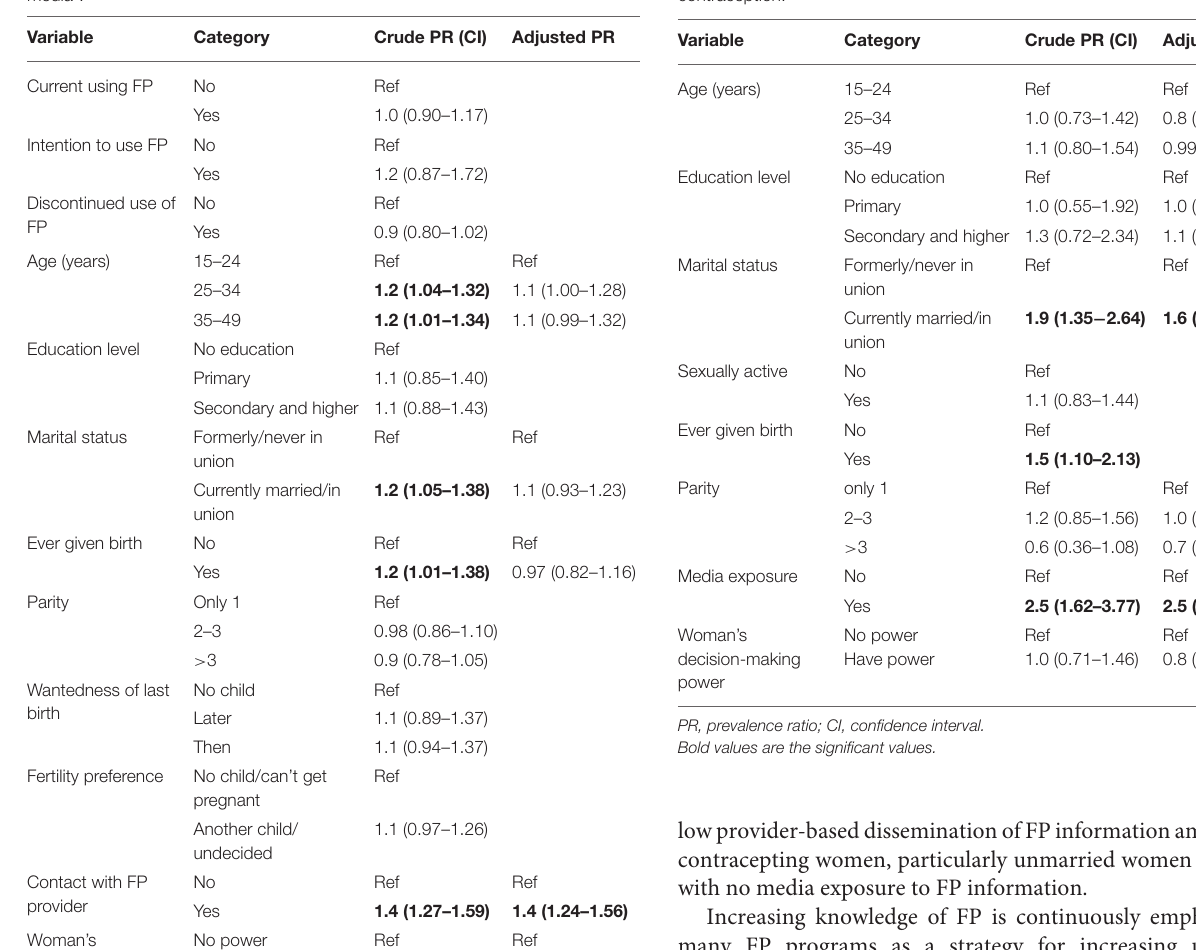
TABLE 6 | Factors associated with FP counseling among non-users of contraception. Variable